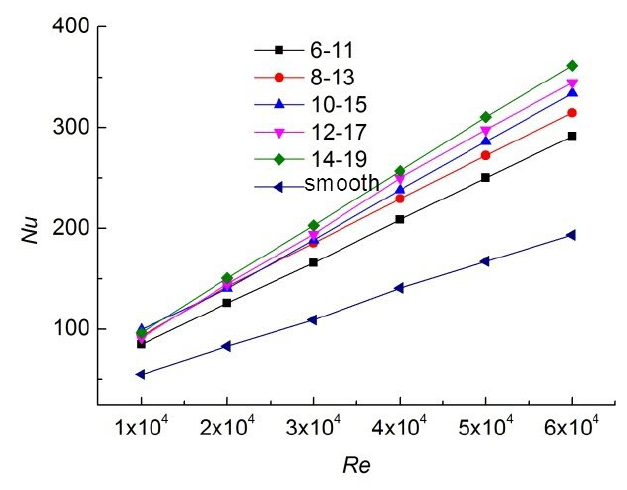
Figure 7. The variation of Nusselt number in shell with Re.